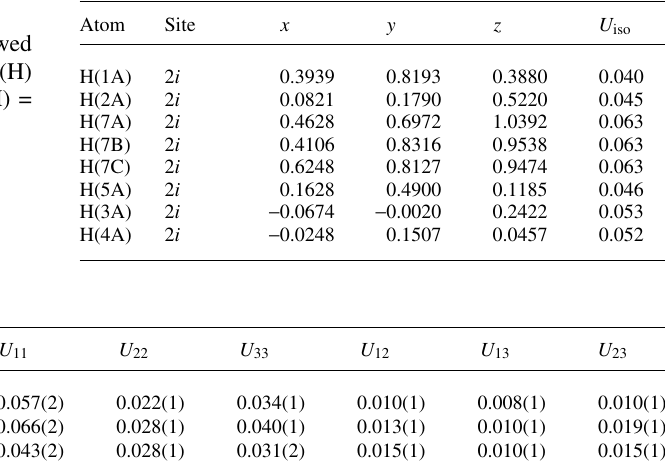
Table 2. Atomic coordinates and displacement parameters (in Å 2 ) .